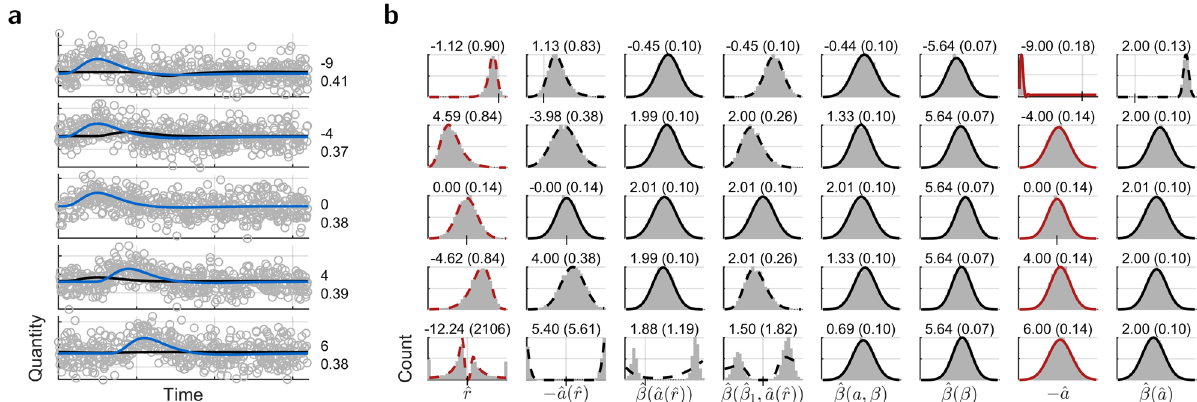
Figure 2. Monte-Carlo simulations for parameters from time derivative and optimization for single HRF. ( a ) Example time courses in time windows of 32 s starting at a negative latency or zero. Black curves are estimates from standard HRF. Numbers indicate true latency in seconds and signal-to-noise ratio, ( b ) Parameter 2 . Left to Right , ( b1 ) Coefficient ratio (6), ( b2 ) Latency, ( b3 ) Magnitude estimated on histograms for β = 1 , ( b5 ) Enhanced shifted HRF regressors with latency from ( b2 ), ( b4 ) Magnitude by calibration (7) from i = HRF coefficient (A21), ( b6 ) Magnitude by power (8), ( b7 ) Optimized latency with envelope from the variance relation (9), ( b8 ) Magnitude estimated on shifted HRF regressors with latency from ( b7 ). Beyond the limits, the signs of enhanced HRF coefficient and magnitude by power are reversed, as they follow the sign change in the HRF coefficient. Outliers in the optimized parameters disappeared when the search for an initial value (see Methods) extended over the true latency. Titles show median and standard deviation. Vertical ticks and grid lines indicate zero. Red envelopes are theoretic, and black envelopes are least-squares fits. Line style indicates the better fit by a normal distribution (solid), or a normal ratio distribution